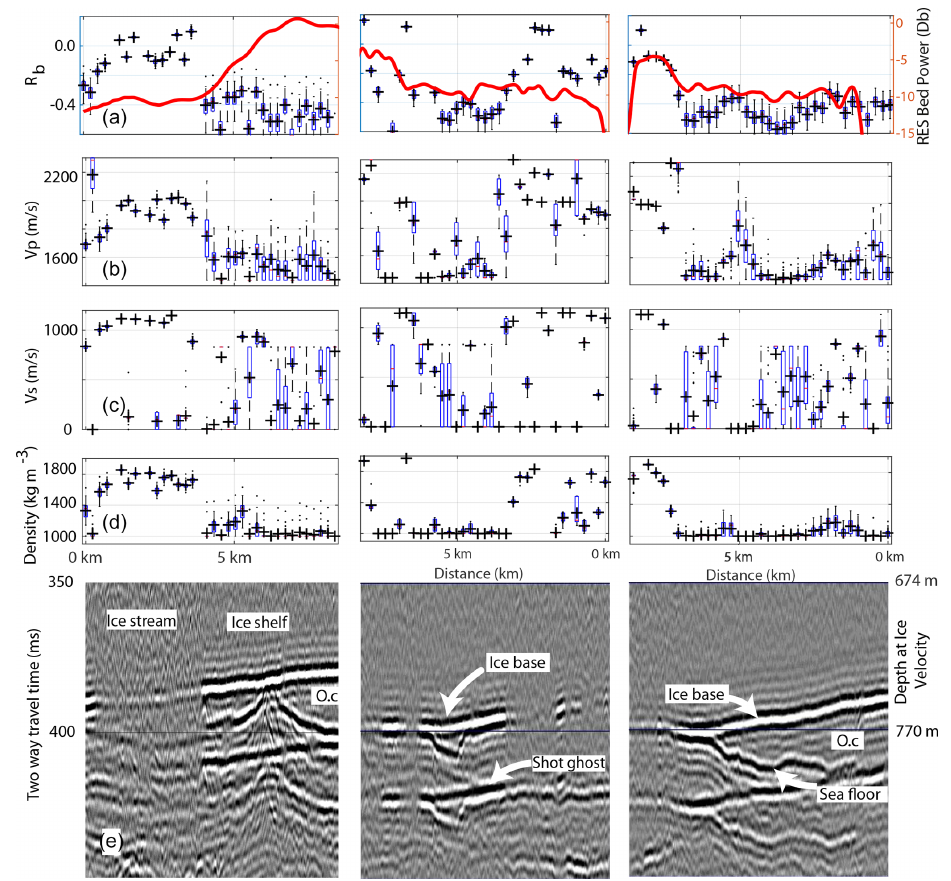
Figure 7. Lines 2 (left), 3 (middle), and 4 (right). (a) Seismic basal reflectivity at normal incidence estimated from the average value within 10 ◦ ( R b ). The red line shows radar basal reflectivity from Christianson et al. (2016). (b–d) Box plots of V p , V s , and ρ estimated using Zoeppritz fitting and all estimated source sizes. Blue boxes show the 25th and 75th percentiles, whiskers extend to cover data points, and outliers are plotted as black points. Solutions using the mean source size are overlain as black crosses. All estimates use source sizes obtained using the known reflector method. (e) Stacked active-source seismic reflection profile. Line 2 is plotted flowing from grounded (left) to floating (right). Lines 3 and 4 are plotted with flow into the page. Shot ghost denotes the short-path multiple generated by the ray path from the source to the ice–air interface and then down. O.c denotes the ocean cavity. For locations see Fig.